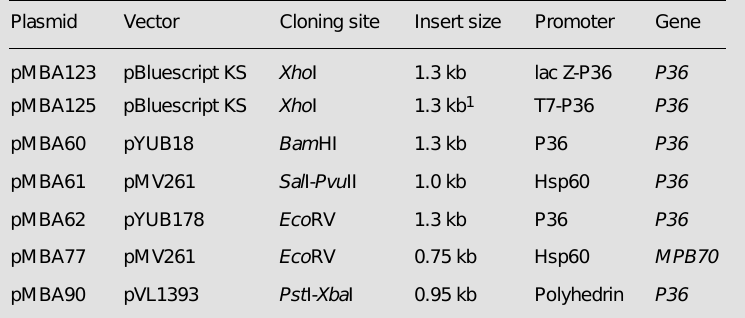
Table 1 - Main features of plasmid